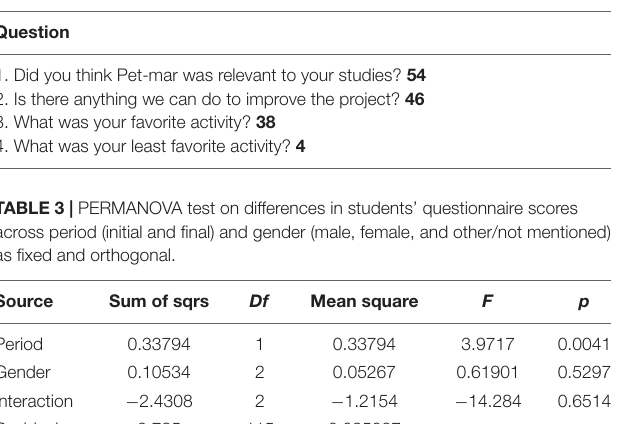
TABLE 2 | List of questions asked on Q3, along with the number of children who chose to answer each question in bold. Question